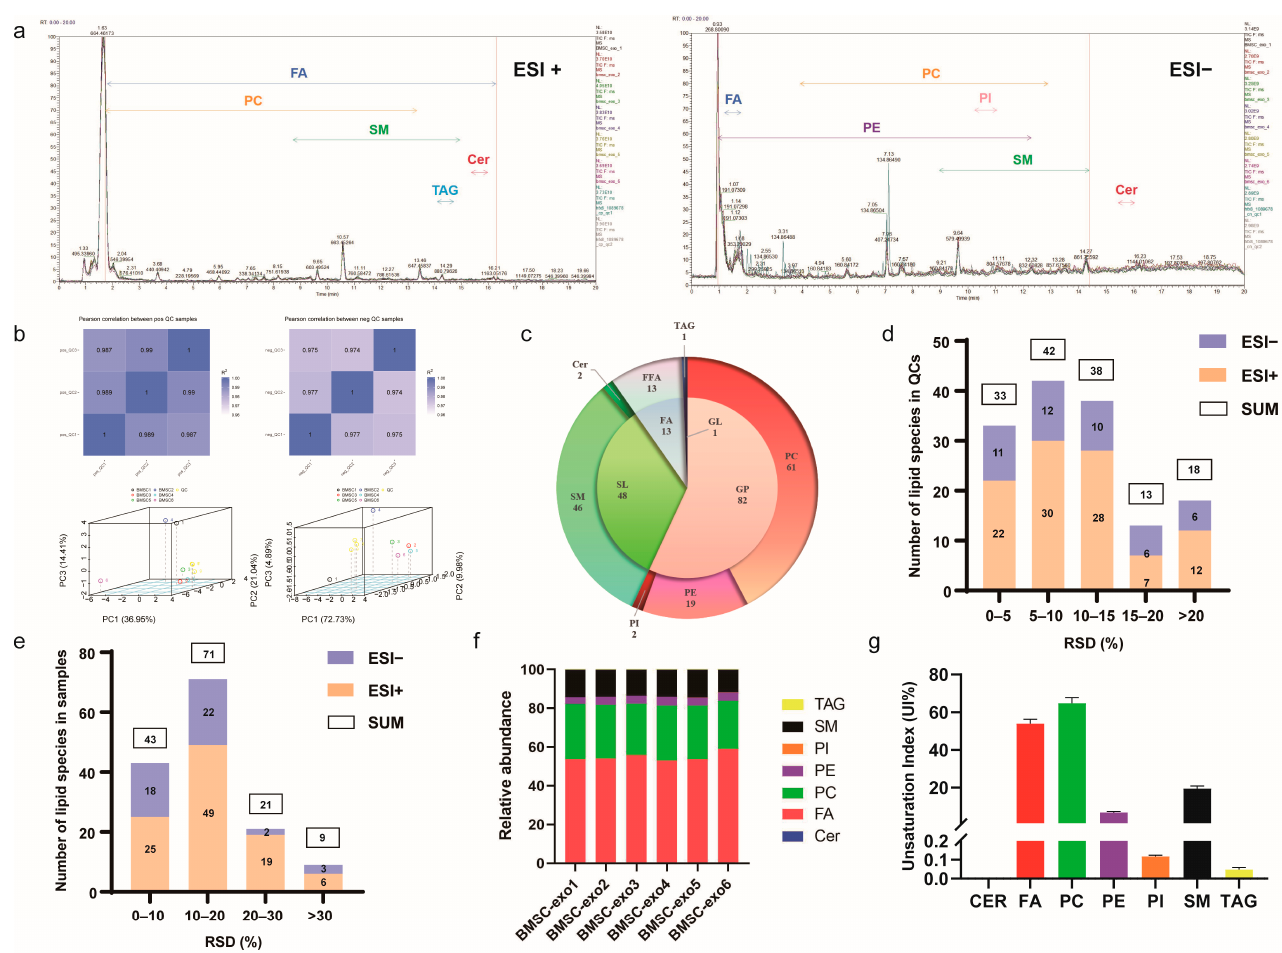
Figure 3. Lipidomics analysis of BMSC-exos samples. ( a ) Total ion chromatograms (TICs) of lipid profiles in BMSC-exos were obtained using UHPLC-MS/MS (ESI+ and ESI − ). ( b ) Correlation between QC samples and PCA analysis of all samples, including QCs. ( c ) Lipid classes and species distributions identified from BMSC-exos samples. ( d ) RSD distribution of lipid species detected in all QC samples (n = 3). ( e ) RSD distribution of lipid species detected in different BMSC-exos samples (n = 6). ( f ) Distribution of lipid species and abundance in BMSC-exos. ( g ) Unsaturation index (UI) of different lipid classes in BMSC-exos.